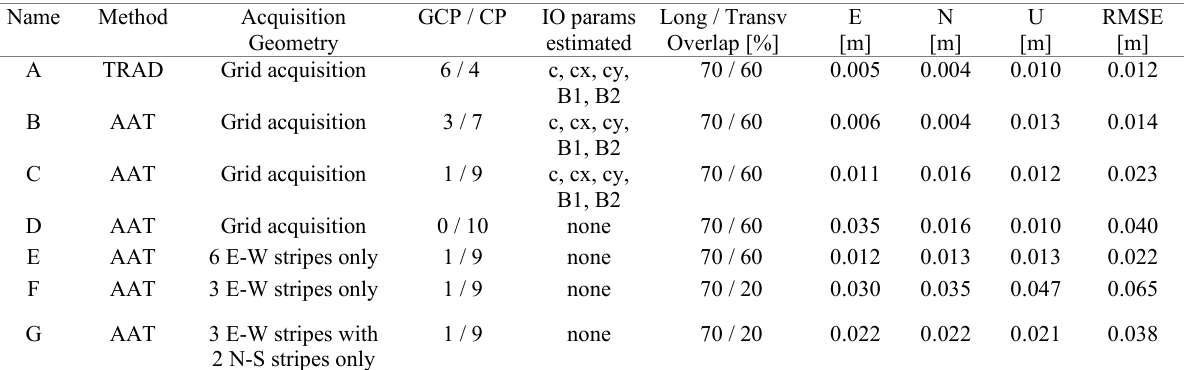
Table 4. Results of the validation of the AAT procedure on the validation flight for the different block